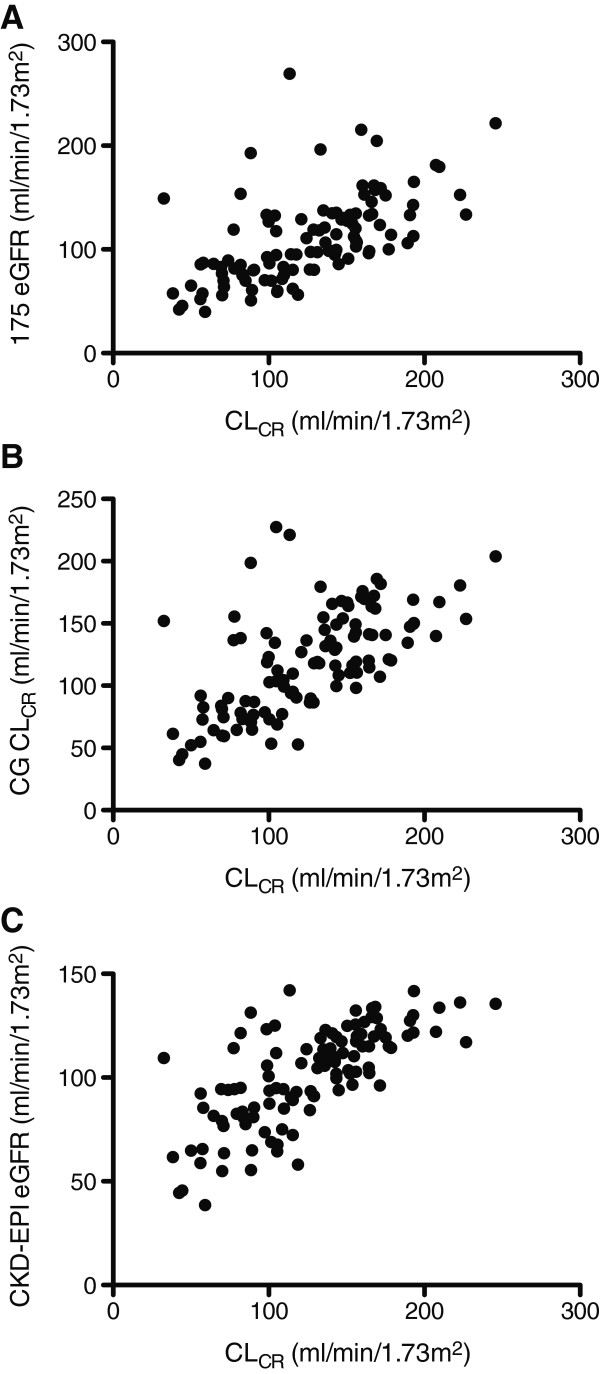
Scatter graphs of CLCR versus mathematical estimates in all patients. CLCR on the x-axis compared with 175 eGFR (panel A), CG CLCR (panel B), and CKD-EPI eGFR (panel C), on the y-axis. CLCR = 8-hr Creatinine Clearance, 175 eGFR = Abbreviated Modification of Diet in Renal Disease 175 formula, CG CLCR = Cockcroft-Gault Creatinine Clearance, CKD-EPI eGFR = Chronic Kidney Disease Epidemiology Collaboration Equation.